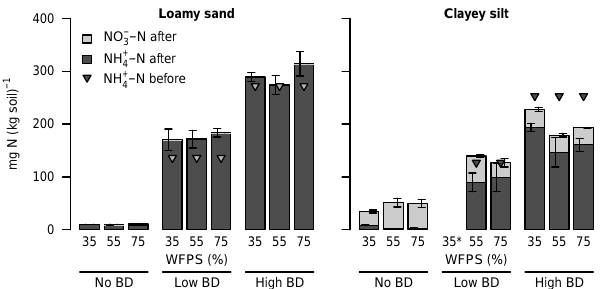
Figure 2. Ammonium and nitrate contents from loamy sand and clayey silt after incubation with different water-filled pore spaces (WFPSs, %) and amounts of digestate (0mL per sample ring: no BD, 17.6mL: low BD and 35.2mL: high BD). Error bars de- note standard deviations. In general, the ammonium content in- creased with digestate application, with lower amounts detected in the clayey silt. Nitrate was found almost exclusively in the latter soil. For comparison, inverted triangles show calculated amounts of applied ammonium, which may differ from actual rates due to het- erogeneity of biogas digestate. One treatment (*) was omitted from all analyses due to technical